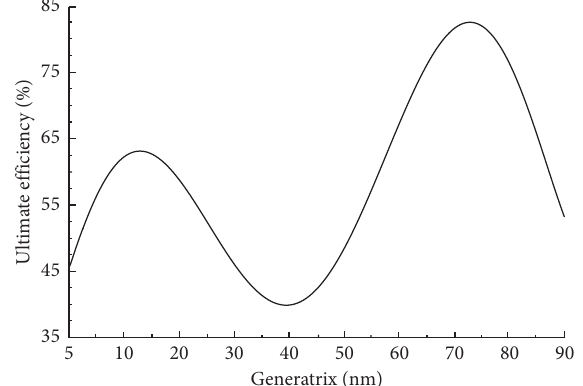
Figure 4: Absorption efficiencies of OSC as a function of generatrix.